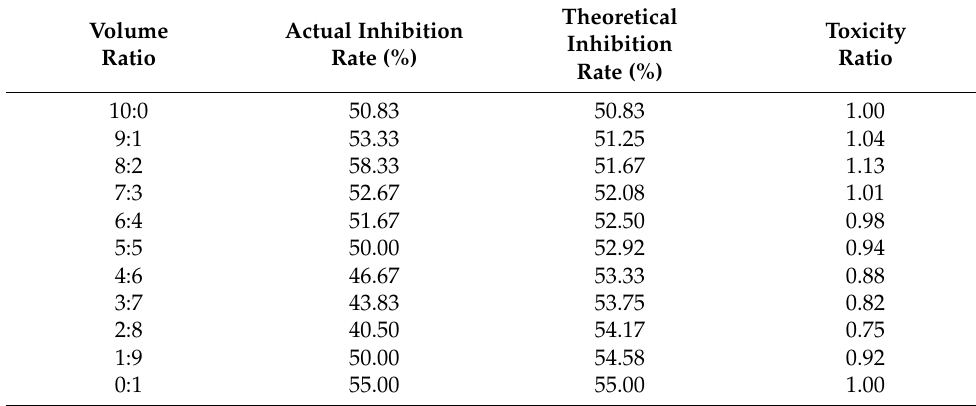
Table 4. Toxicity ratio of nanosilver and iprodione against V. mali.